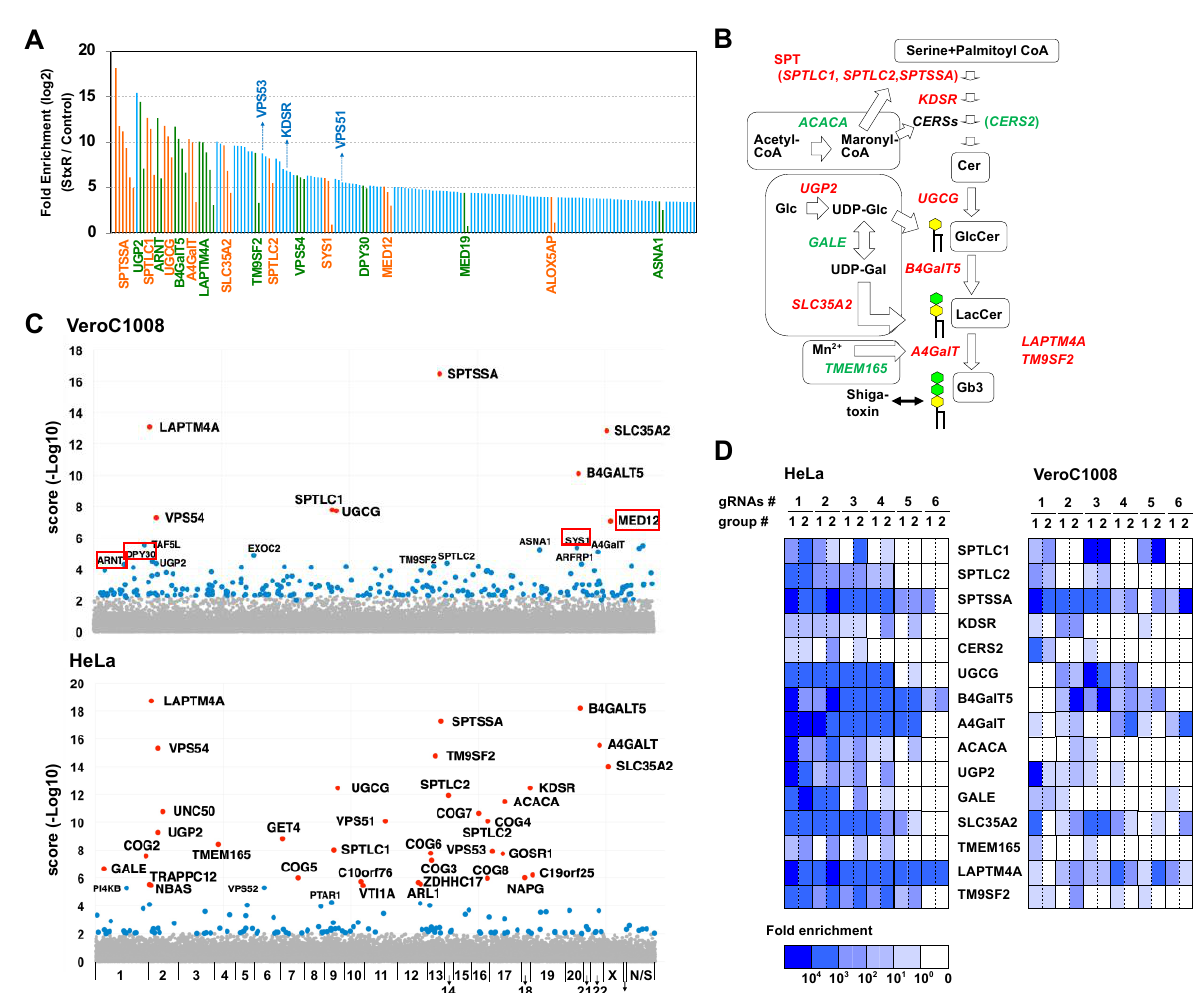
Figure 1. Identification of STx resistance genes in the genome-wide CRISPR screen. ( A ) Identification of sgRNAs enriched in the screen using Vero C1008 cells. Fold enrichment represents the mean of two independent experiments. Orange and green bars indicate that multiple sgRNAs were enriched in a gene, while blue bars indicate that a single sgRNA was enriched in a gene. The full raw data set is shown in Data S1A – C. ( B ) Gb3 biosynthetic pathway. Genes enriched in the Vero screen as well as the previous HeLa screen [24] are shown in red. Genes enriched only in the HeLa screen are shown in green. ( C ) Manhattan plots of the Vero screen and the HeLa screen. Scores were derived from the MAGeCK analysis shown in Data S1D. Red dots indicate FDR < 0.01. Blue dots indicate p < 0.01 but FDR > 0.01. ( D ) Fold enrichment of six sgRNAs in GSL-related genes enriched in the Vero screen compared with that of the HeLa screen. The heat map is representative of individual sgRNA enrichment (sg1 – 6) in two independent experiments (groups #1 and #2). See also Supplementary Materials.